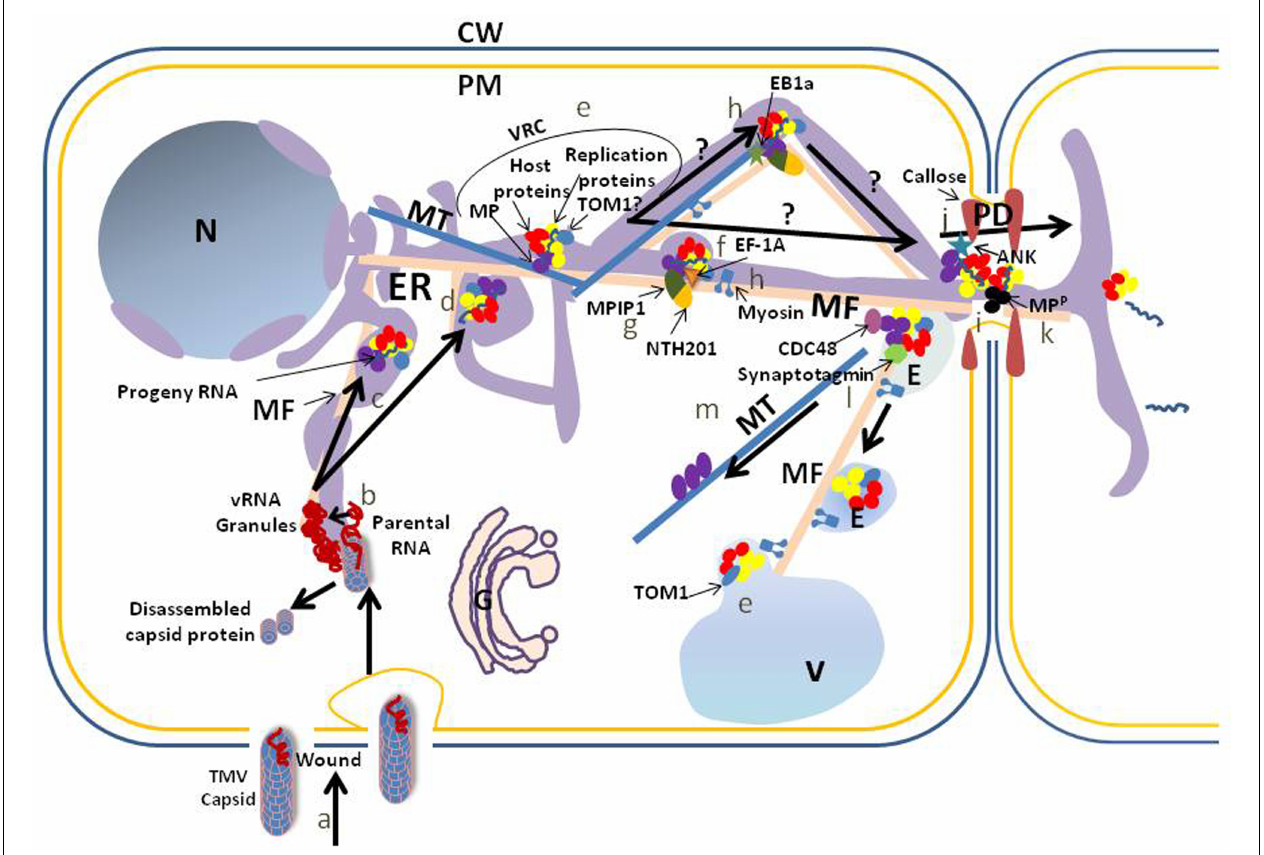
influence is on sustained movement associated with clearance of virus components within the cell, or with initial movement: we have placed it with initial movement and with the MF (f). An interaction between two host proteins, a class II KNOTTED 1-like protein (NTH201) and a DnaJ-like protein (MPIP1), and theTMV MP also may aid transport of virus to the PD (g), although again it is unclear if this interaction aids initial or sustained movement. Movement of theVRC to the PD requires membrane, and may be influenced by actomyosin (MF and myosin) and MT (h).The influence of the MT end-binding protein (EB1a) on virus movement is placed during transport to the PD (h). MP microfilament severing activity at the PD is proposed to eliminate F-actin-like structures at the PD to increase the PD size exclusion limit SEL (i). In addition, interaction between the MP and the ankyrin repeat containing protein (ANK) is correlated with an increase of the PD SEL through a decrease in callose at the PD neck (j). vRNA transports through PD within a VRC or simply with vRNA and MP, the latter being phosphorylated (MP P ) in the PD to release the vRNA for translation in the next cell (k; Karpova etal., 1997; Lee etal., 2005). After vRNA transfer to the neighboring cell,VRC remnants associate with endosomes (E; possibly pre-vacuolar vesicles) for transport to vacuoles, potentially through interaction of the vesicle fusing protein, synaptotagmin, with the MP (l).Transport is proposed to involve the actomyosin network. Likely prior to this transport, CELL-DIVISION CYCLE protein48 (CDC48) extracts the MP from the ER-associatedVRC for attachment to the MT and later degradation (m). N,